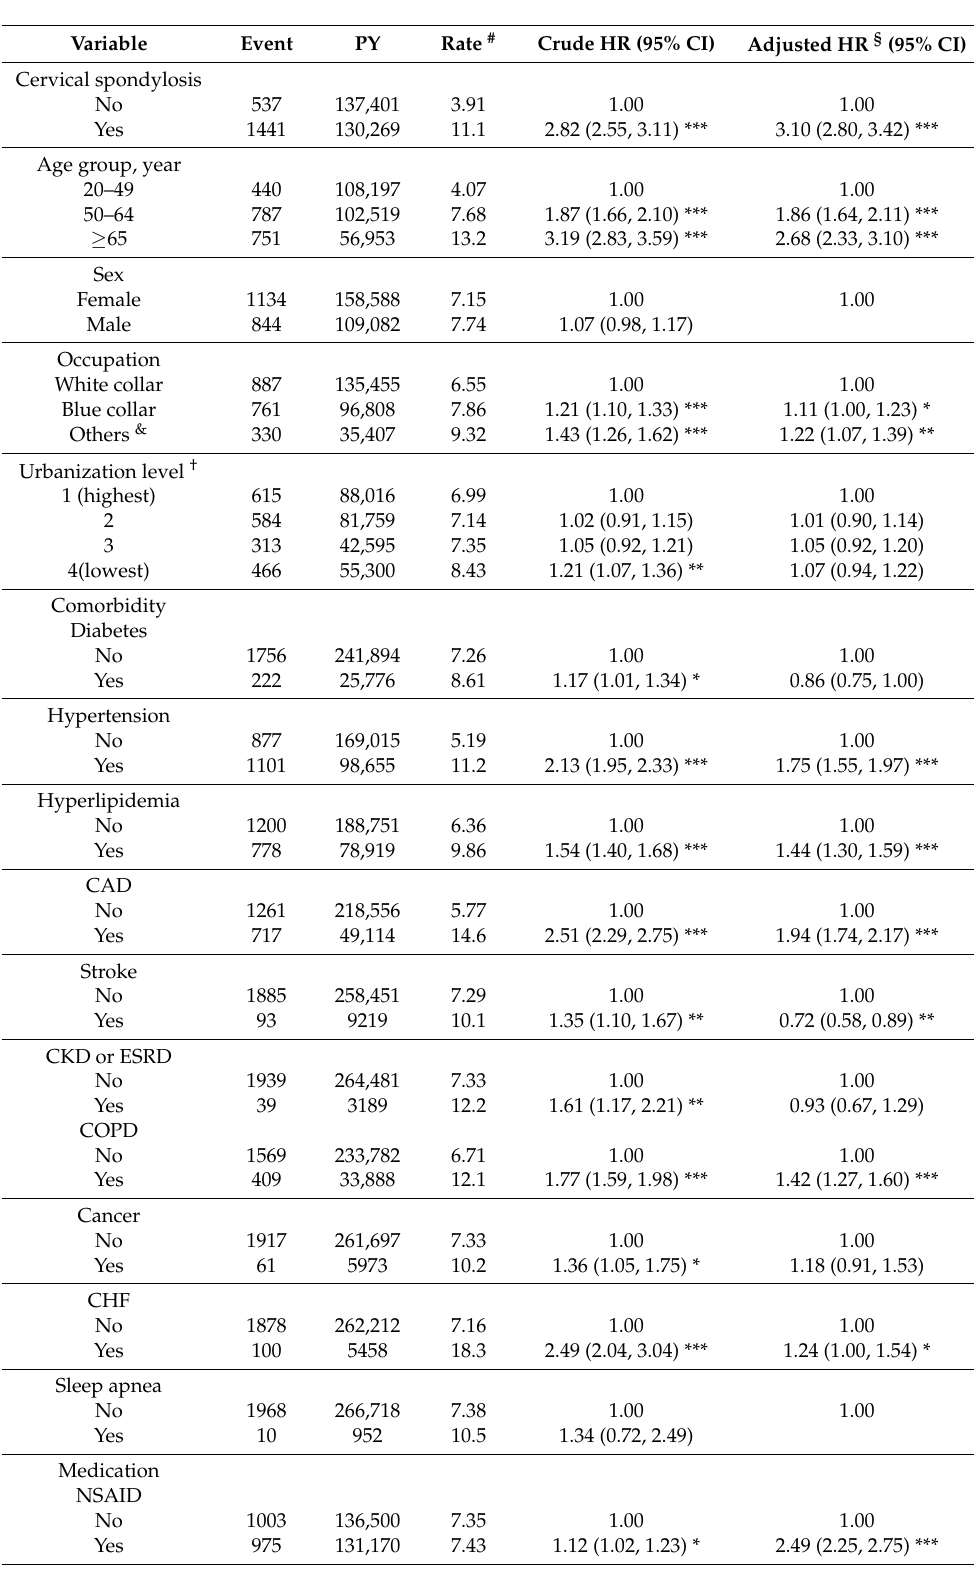
Table 2. Incidence and Hazard ratio for Arrhythmia and Arrhythmia-associated risk factor. Variable Event PY Rate # Crude HR (95% CI) Adjusted HR § (95% CI) Cervical spondylosis No